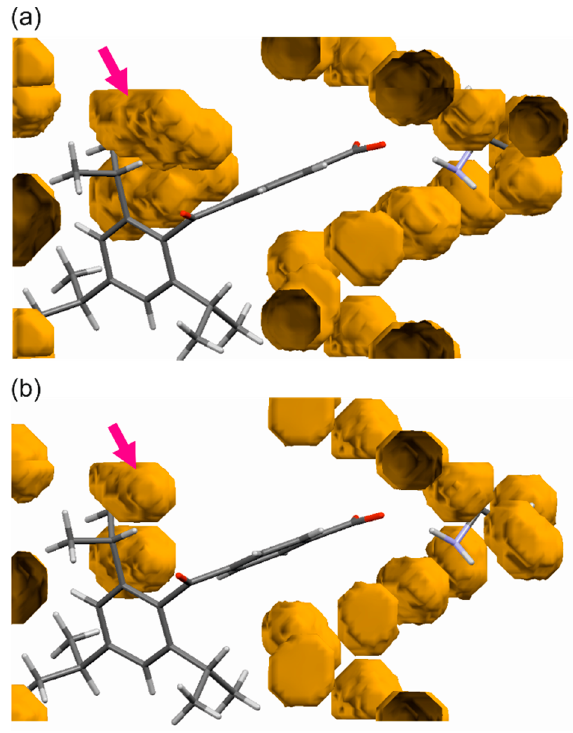
Figure 3. The free space for compound ( 1 ) at ( a ) 0.1 MPa and ( b ) 1.3 GPa. The arrow indicates the void suitable for the Norrish–Yang reaction with 2-isopropyl. The radius of a ball was 0.9 Å and the grid was 0.2 Å [25].